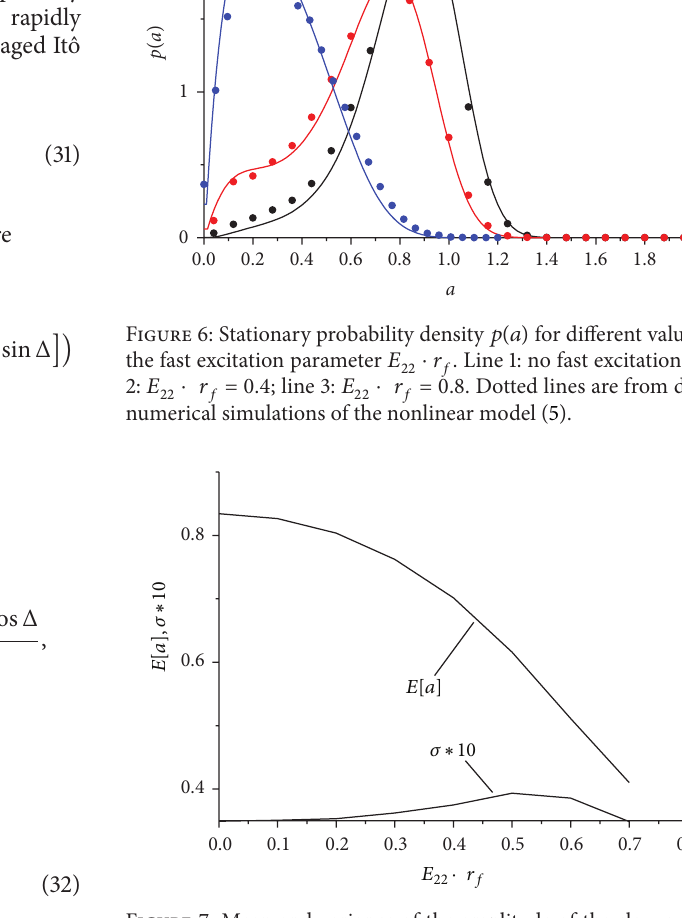
Figure 7: Mean and variance of the amplitude of the slow system